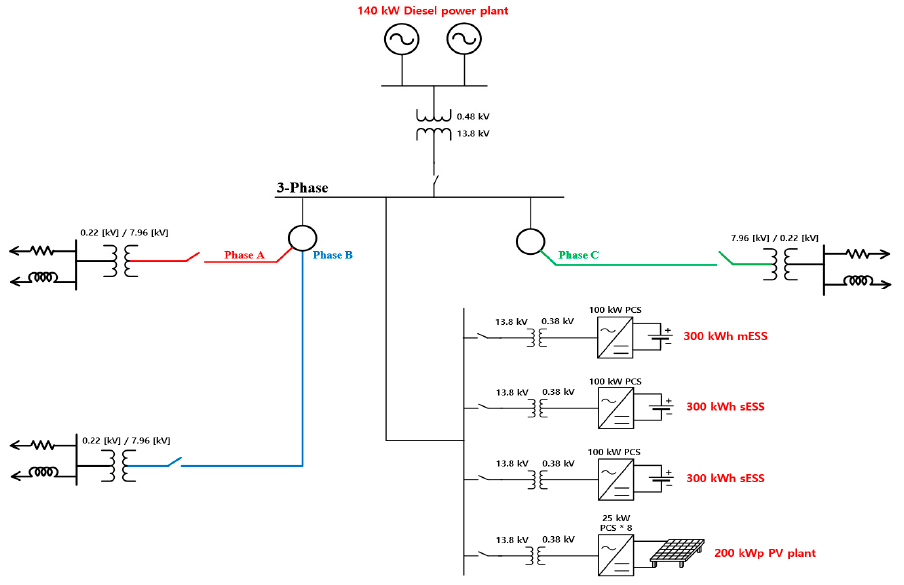
Figure 1. Overview of Floreana Island power system.